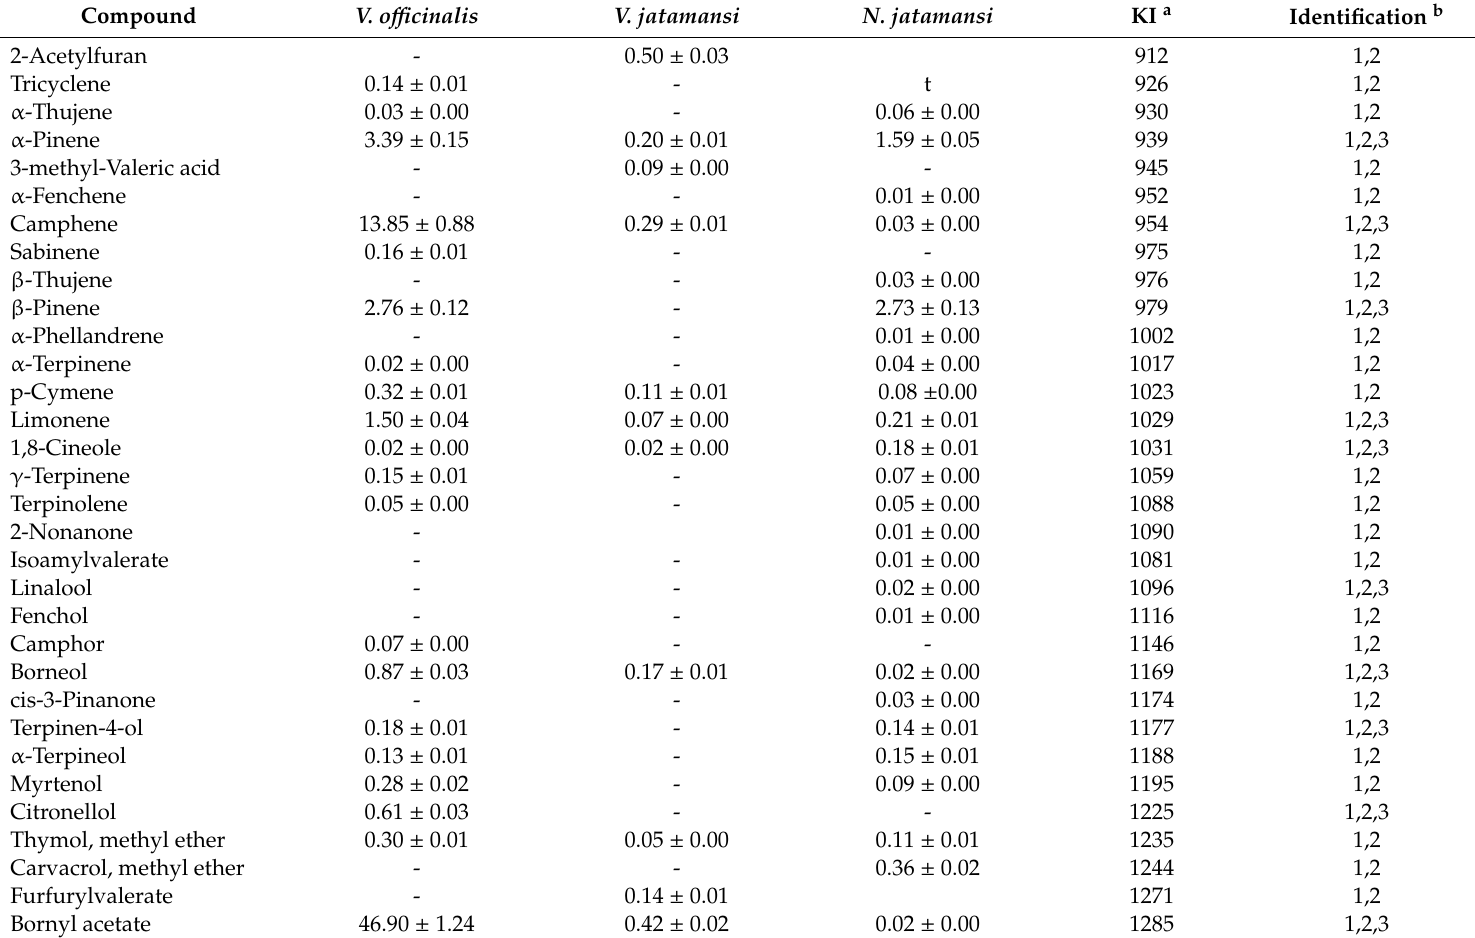
Table 2. Chemical composition of Vo, Vj and Nj EOs. Results are expressed as mean area percentage (%) ± standard deviation (S.D.) of three independent determinations in triplicate (n =